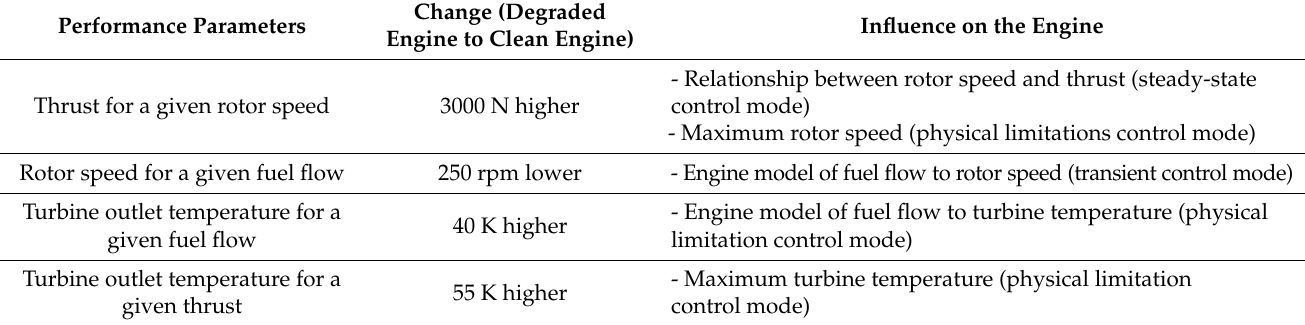
Table 4. The effects of degradation on the performance